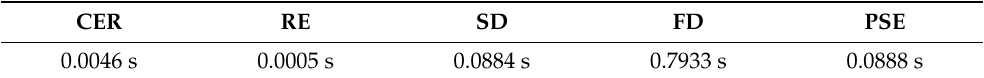
Table 2. Average time required for computation of 1 indicator value from 0.2 s time interval.